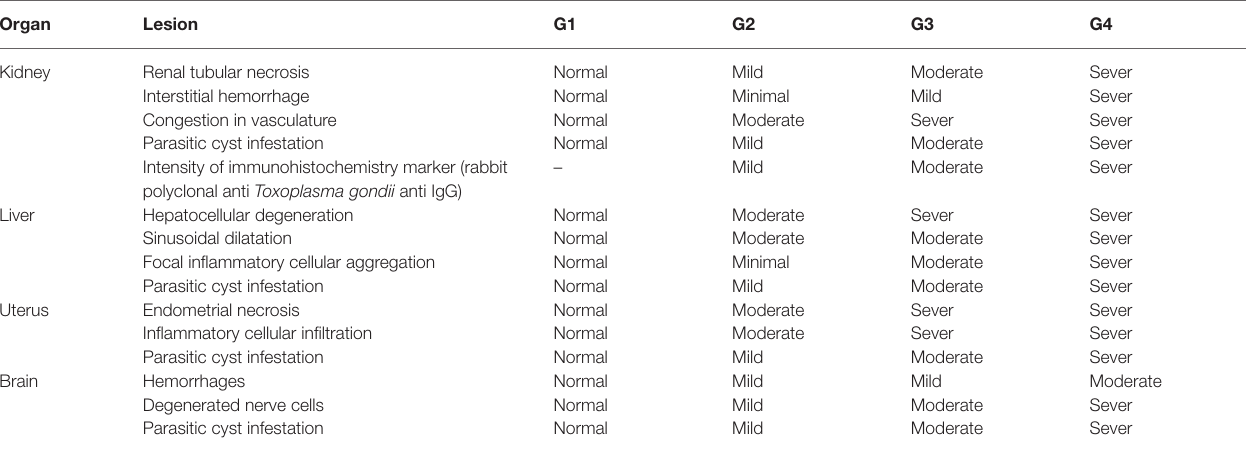
TABLE 3 | Lesions scoring for reported pathological lesions of various organs in the experimental